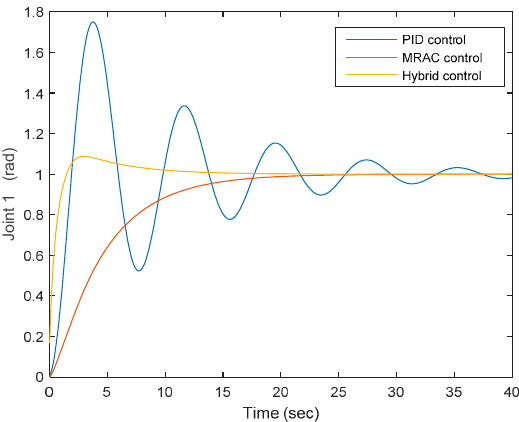
Figure 11. Joint output under three controls—scenario 1.